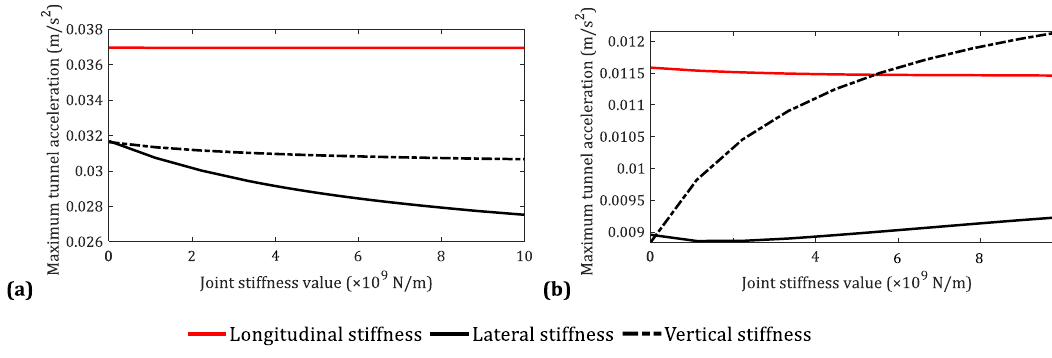
Fig. 20 Influence of tunnel segmental joint stiffness on tunnel lateral acceleration: a tunnel bottom segment; b tunnel sidewall